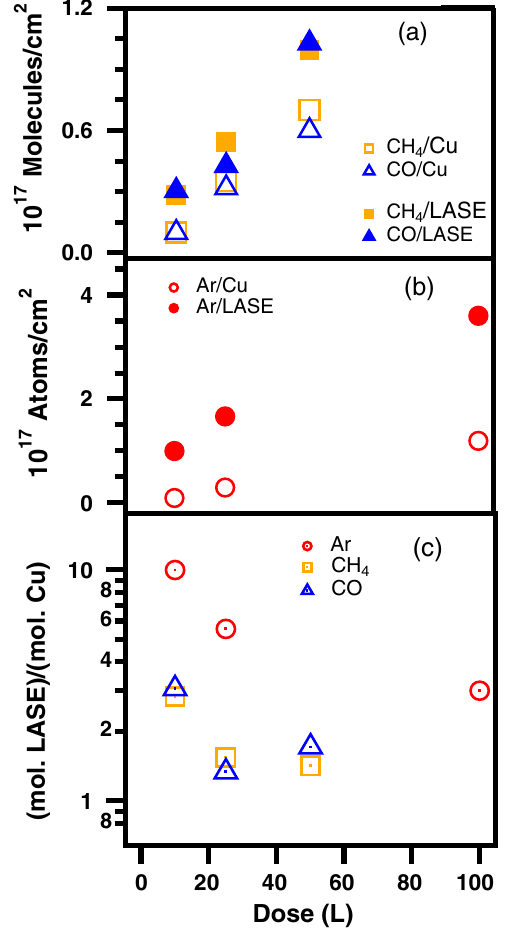
FIG. 7. (a) Total number of CH 4 and CO molecules = cm 2 desorbed from poly-Cu flat surface (open symbol) and from LASE-Cu (full symbols) as a function of gas dose. (b) Total number of Ar atoms = cm 2 desorbed from poly-Cu flat surface (full symbol) and from LASE-Cu (open symbols) as a function of gas dose [36]. (c) Ratio between the number of CH 4 and CO molecules (Ar atoms) desorbed from LASE-Cu and poly-Cu sample as a function of gas